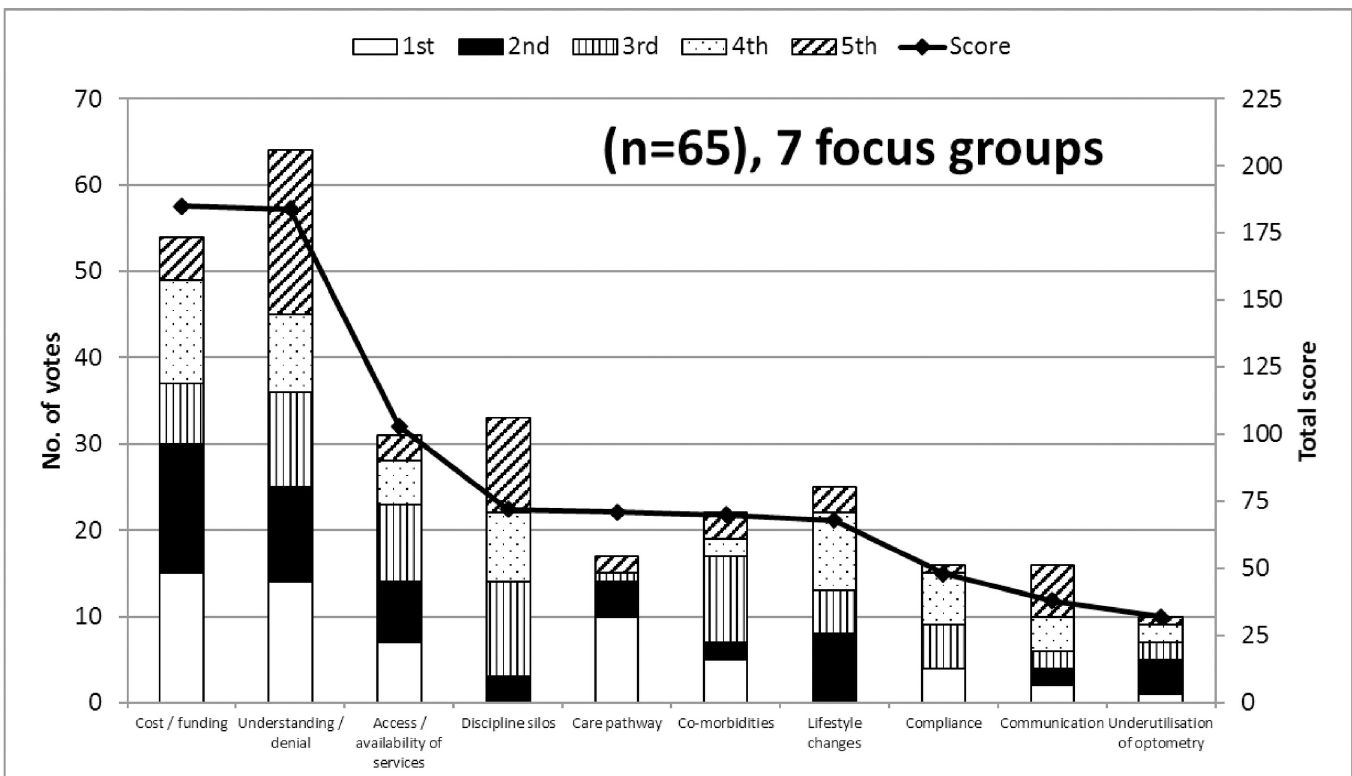
Fig 1. Optometrists’ perspectives on barriers to AMD care. The most frequently cited (primary y-axis) and highest scoring (secondary y-axis) top 10 themes (representing barriers to AMD care) generated by the 7 optometry focus groups. The y-axis on the left is associated with the bars and represents the number of optometrists that identified these themes in their top five barriers and includes the detail of how many participants ranked each theme first (white), second (black), third (vertical lines), fourth (dots), and fifth (diagonal lines). The y-axis on the right is associated with the line and represents the top 10 total score given by focus group participants, based on how important optometrists felt these were (high score = high